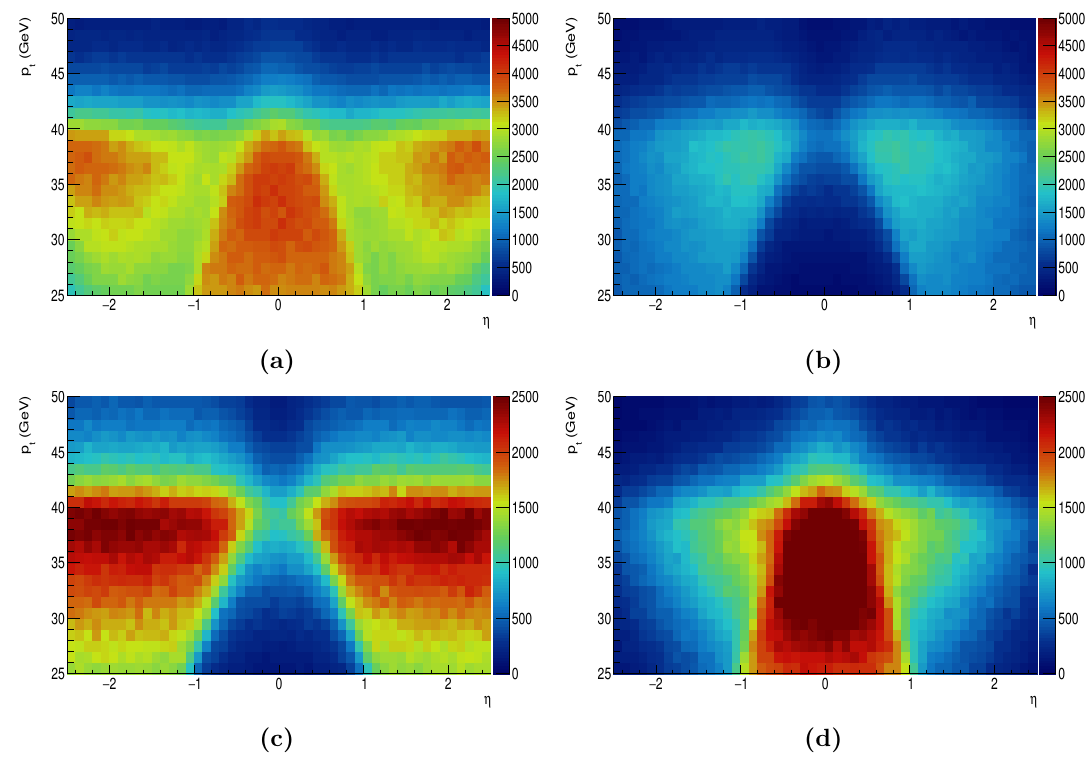
Figure 2 . p t vs. (cid:17) distribution for leptons from W decays. a) W + with negative helicity. b) W + with positive helicity. c) W (cid:0) with negative helicity. d) W (cid:0) with positive